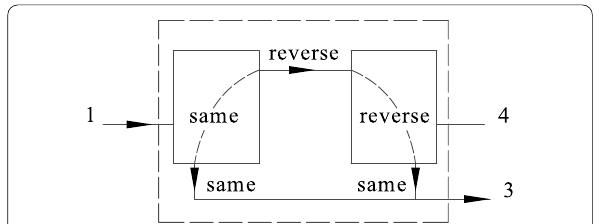
Figure 6 Internal power flow in the generic